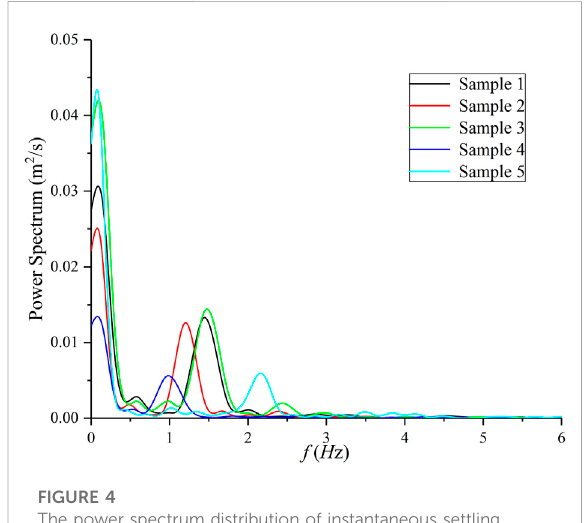
FIGURE 4 The power spectrum distribution of instantaneous settling velocities of fi ve